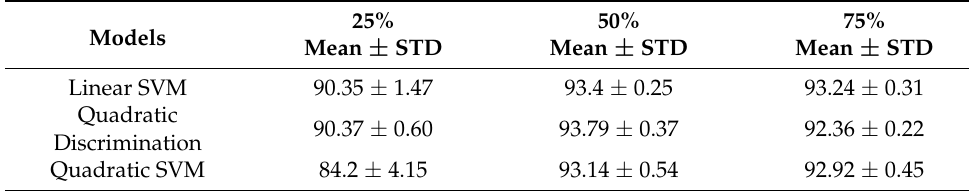
Table 4. Best results obtained with all the samples.